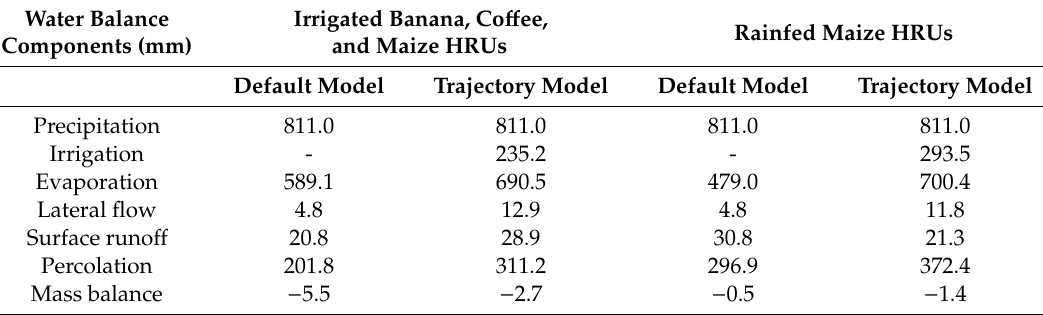
Table 9. Comparison of the water-balance components in SWAT + at HRU